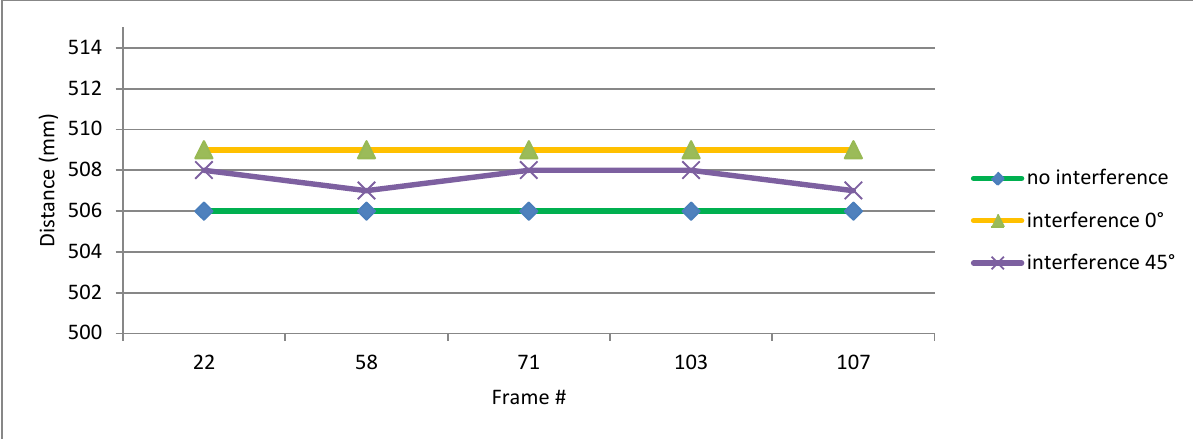
Figure 4. Repeatability of the measurement of the distance of two spheres. Three different scenarios are tested: no interference, i.e. only one sensor is switched on, interference from a sensor at 0 degree tilt angle and interference from a sensor at 45 degree tilt